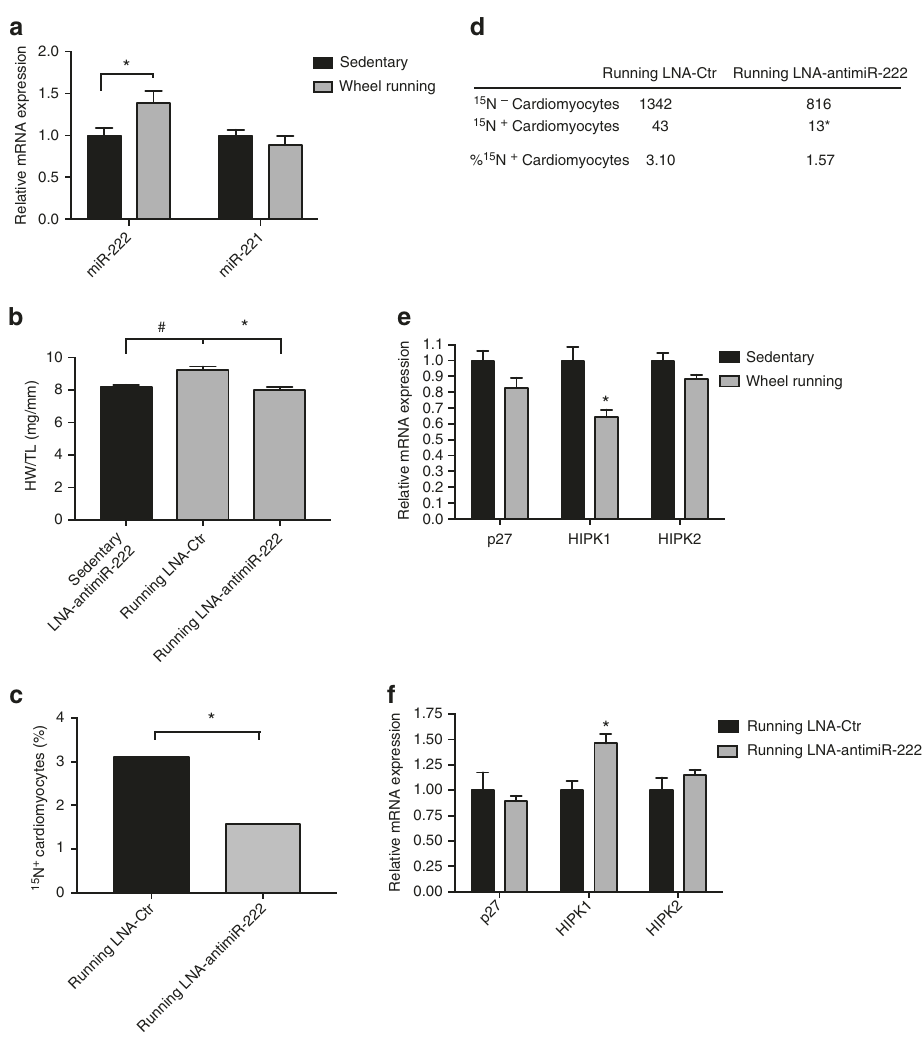
Fig. 4 Inhibition of miR-222 prevents exercise-induced cardiomyogenesis. a miR-222 is upregulated after eight weeks of voluntary wheel running in young adult mice ( n = 6 mice per group, * p = 0.01, Student ’ s t test). b Mice underwent simultaneous 15 N-thymidine infusion and LNA-anti-miR-222 or control LNA-anti-miR (LNA-Ctr) treatment for 8 weeks of sedentary activity or voluntary wheel running. miR-222 inhibition blocks physiologic cardiac hypertrophy measured by heart weight/tibia length (HW/TL) ( n = 5 mice per group, * p < 0.05 running LNA-anti-miR-222 vs. running LNA-Ctr, # p < 0.05 running LNA- Ctr vs. sedentary LNA-anti-miR-222, one-way ANOVA with Tukey ’ s post-test for multiple comparisons). c Similar to exercise only, exercised mice injected with LNA-Ctr for 8 weeks show an increase in 15 N-thymidine-positive cardiomyocytes. However, exercised mice treated with LNA-anti-miR-222 demonstrate a reduced number of 15 N-thymidine-positive cardiomyocytes closer to sedentary baseline levels (800 – 1350 cells from four mice per group were counted * p = 0.0255, Fisher ’ s exact test). d Contingency table showing the absolute numbers and percentage calculations of 15 N-positive and 15 N- negative cardiomyocytes. e Exercised mouse hearts show downregulation of miR-222 target HIPK1. Bar graph depicting quantitative results from gene expression analysis from heart lysates after 8 weeks of voluntary wheel running demonstrates signi fi cant downregulation speci fi cally of HIPK1 ( n = 3 mice per group, * p < 0.05, Student ’ s t test). f miR-222 inhibition during 8 weeks of voluntary wheel running leads to HIPK1 overexpression ( n = 5 mice per group, * p < 0.05, Student ’ s t test). Error bars represent ±